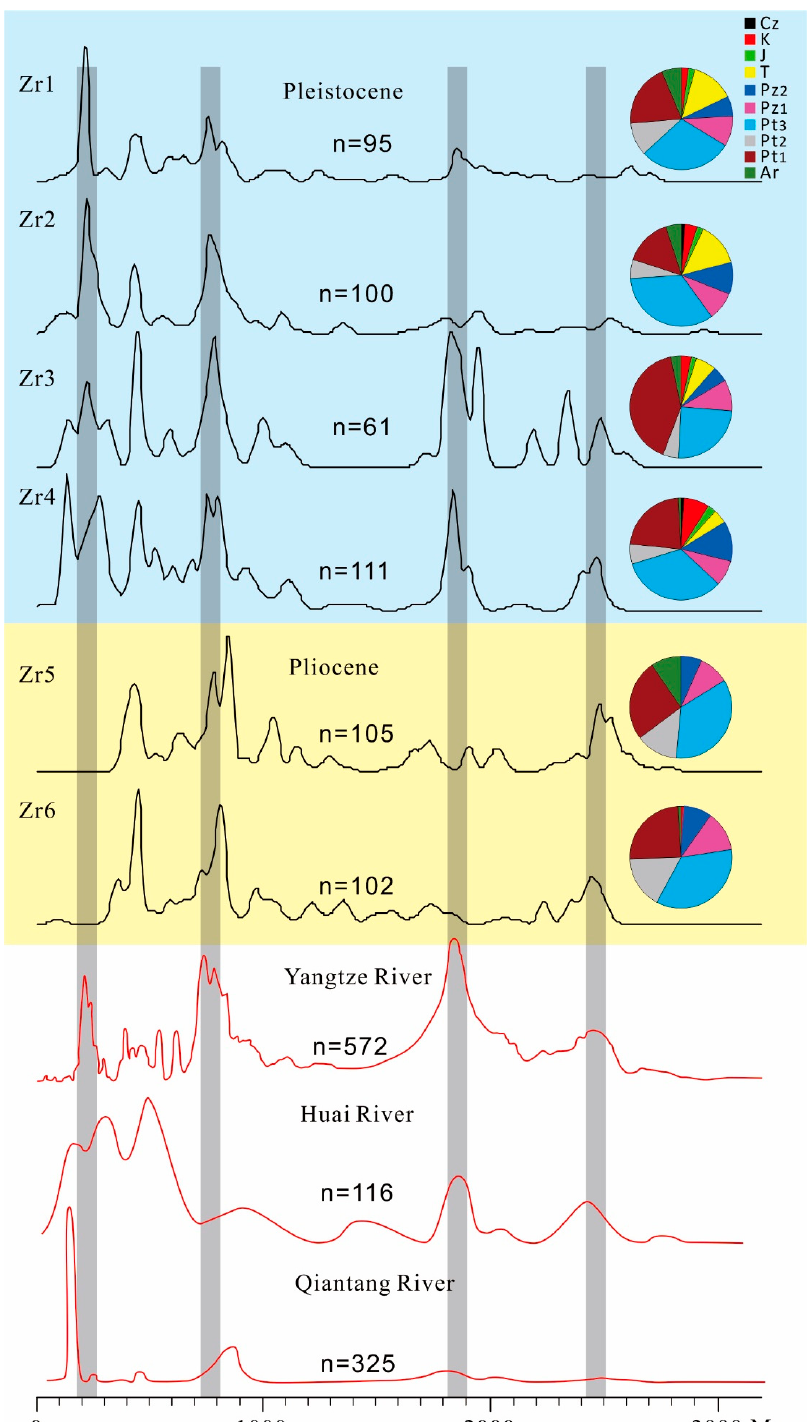
Figure 5. Kernal density estimate and pie diagrams of detrital zircon ages from samples of the core RGK15 and the potential sediment provenance. Data for the Yangtze River, Huaihe River (representative of provenance from the north region) and Qiantang River (representative of provenance from the ancient Zhejiang-Fujian Uplift) are sourced from [28 – 30], respectively.